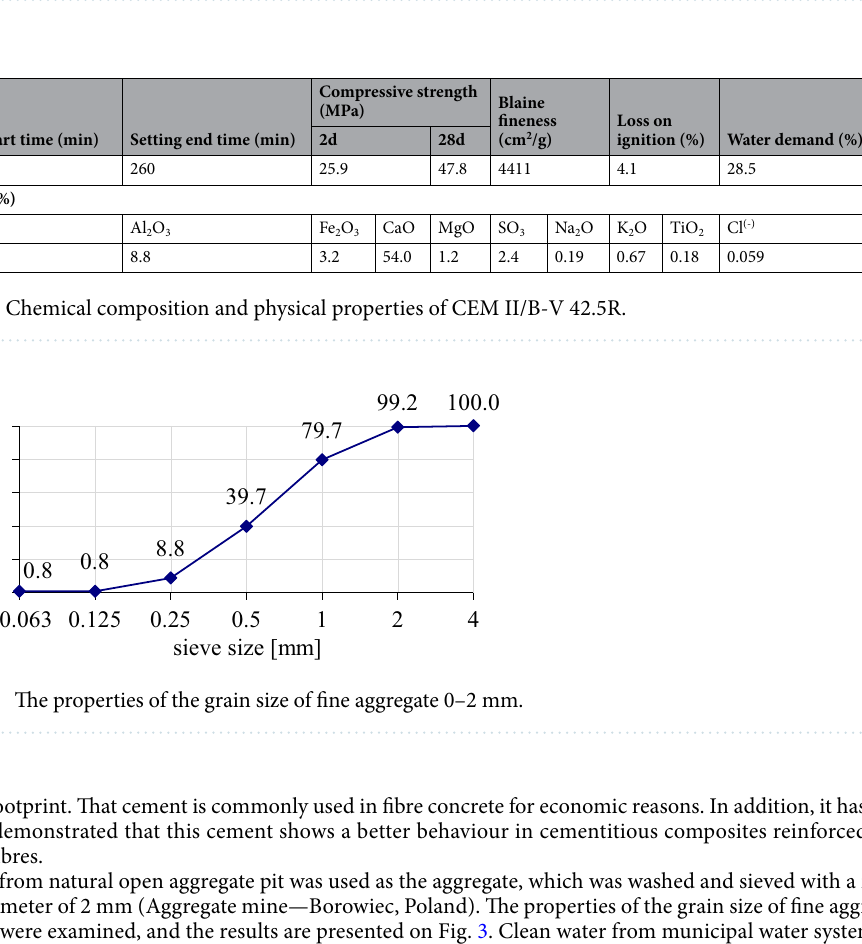
Table 1. Properties of fibres used in research. * ) was used multifilament polymer fibre 12-bundles with a total diameter of 0.01.